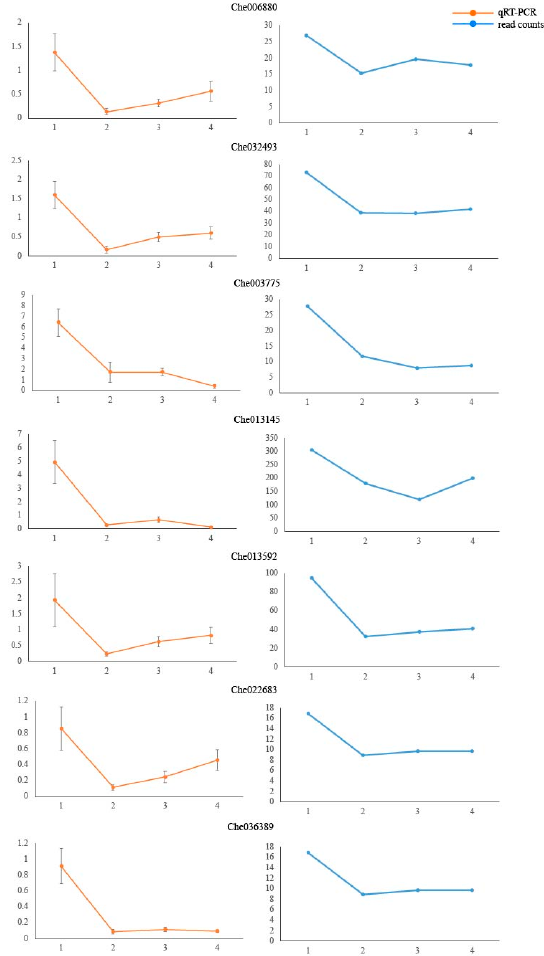
Figure 7. Quantitative real-time polymerase chain reaction analysis of the expression of starch synthesis-related genes. Analyses were completed in triplicate, and the error bars represent the standard errors.